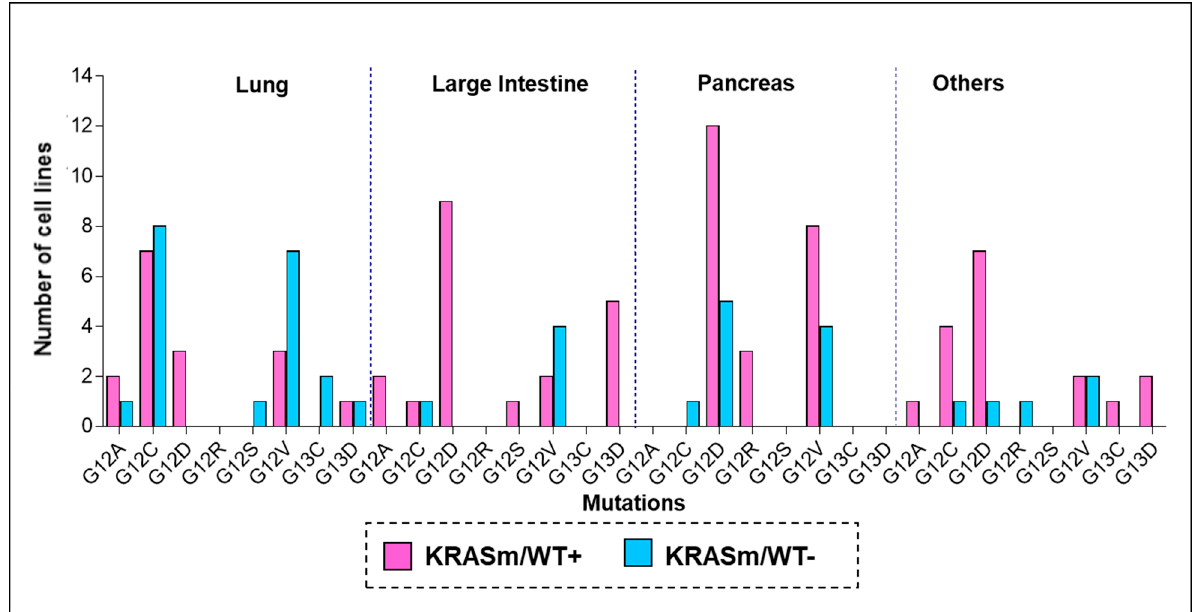
Figure 1. Frequency of KRAS oncogenic mutations across cancer cells lines of different origin. To explore frequency and distribution of KRASm/WT+ and KRASm/WT − mutations across tumor types, KRAS zygosity was retrieved from the COSMIC and the NCI-funded KRAS initiative databases. Mutant KRAS cell lines were classified based on the presence ( KRASm/WT+ pink) or absence ( KRASm/WT − blue) of the KRAS WT allele. Frequencies of KRASm/WT+ and KRASm/WT − cell lines are displayed as bar graphs; mutations are listed on the x-axis, and number of cell lines identified for each variant is reported on the y-axis. Of the 116 identified cell lines, 38 were derived from lung lesions (32.7%), 33 from pancreatic cancers (28.4%), and 25 from tumors of the large intestine (21.5%). The 36 lung cancer models included in the analysis were established from the following tumors: 22 adenocarcinomas, 4 large cell carcinomas, 2 small cell lung cancers, 2 carcinomas not otherwise specified, 2 giant cell carcinoma, 1 adeno-squamous, 1 squamous carcinoma, 1 carcinoid and 1 epidermoid tumor.